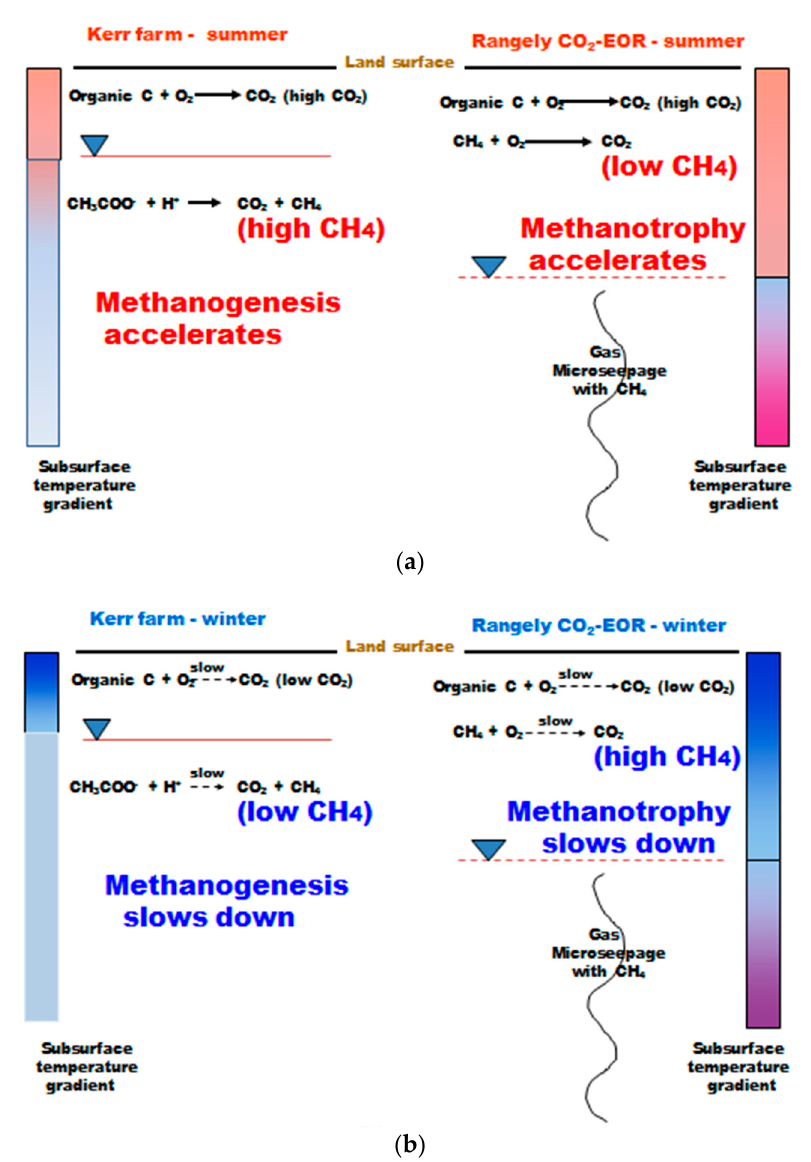
Figure 16. Schematic of seasonal gas seepage processes operating at Weyburn and Rangely and qualitative soil temperature gradients, ( a ) summer, ( b ) winter.